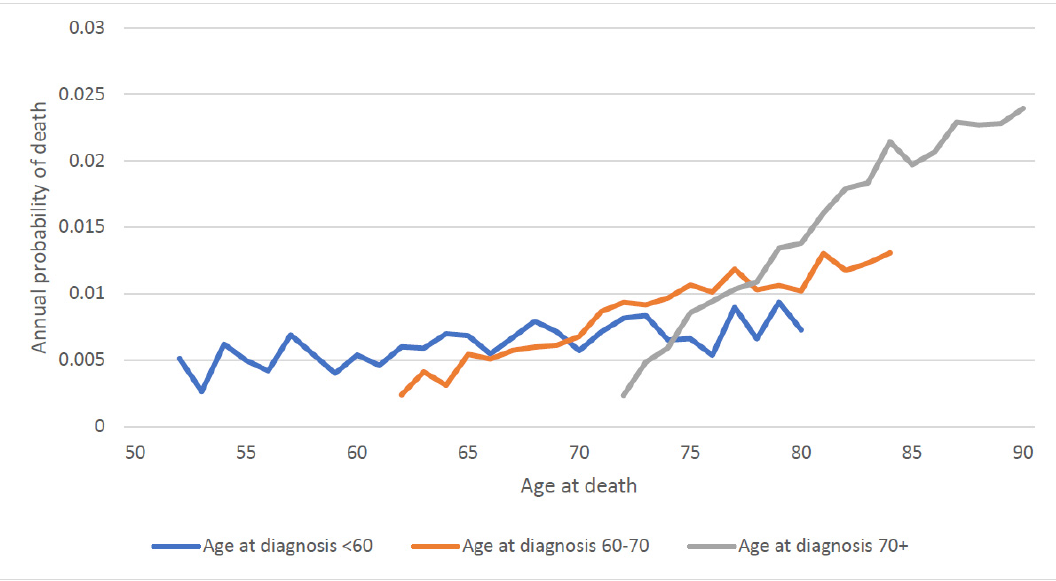
Figure 6. Annual prostate specific mortality by attained age and age of diagnosis.